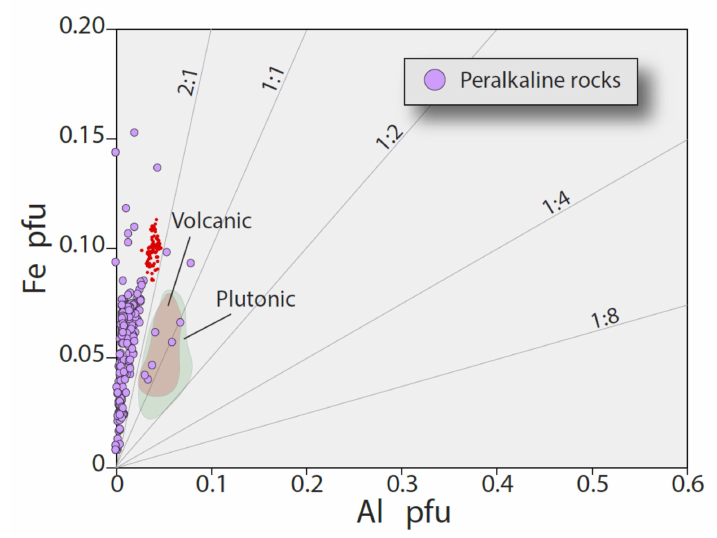
Figure 8. Fe versus Al for titanite from peralkaline igneous rocks compared with fields (90% of data) for titanite from other volcanic (red shading) and plutonic rocks (green shading). Titanite from peralkaline rocks typically has Fe/Al > 2:1. It is possible that the clump of volcanic data (red dots) that plot with Fe/Al > 2:1 is also peralkaline, but these data points were collected from altered volcanic tuffs (bentonites) from the Jurassic Morrison Formation where the original rock compositions are difficult to